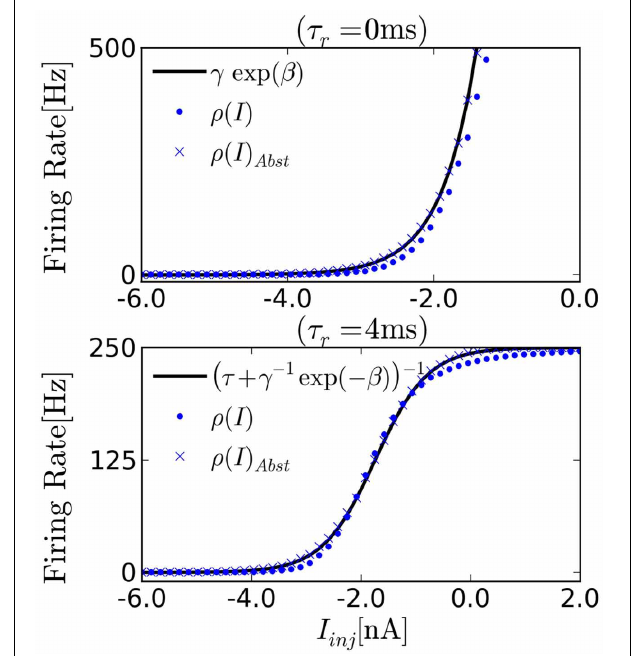
FIGURE 2 | Transfer function of I&F neurons driven by background white noise Equation (5). We measure the firing rate of the neuron as a function of a constant current injection to estimate ρ ( u 0 ) , where for constant I inj , u 0 = I inj / g L . (Top) The transfer function of noisy I&F neurons in the absence of refractory period [ ρ ( u ) = r ( u ) , circles]. We observe that ρ is approximately exponential over a wide range of inputs, and therefore compatible with neural sampling. Crosses show the transfer curve of neurons implementing the abstract neuron Equation (1), exactly. (Bottom) With an absolute refractory period the transfer function approximates the sigmoid function. The firing rate saturates at [250]Hz due to the refractory period chosen for the